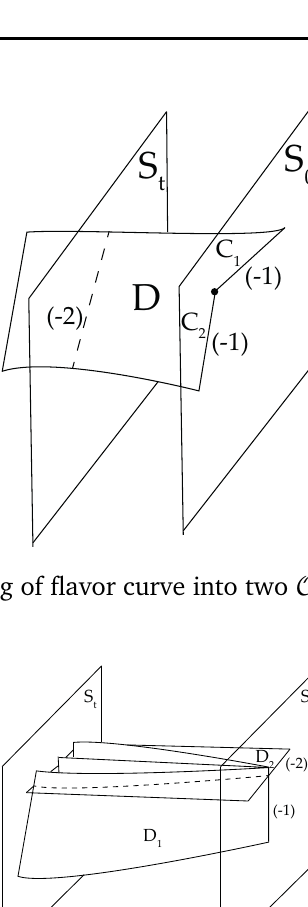
singularity gives rise to an 4